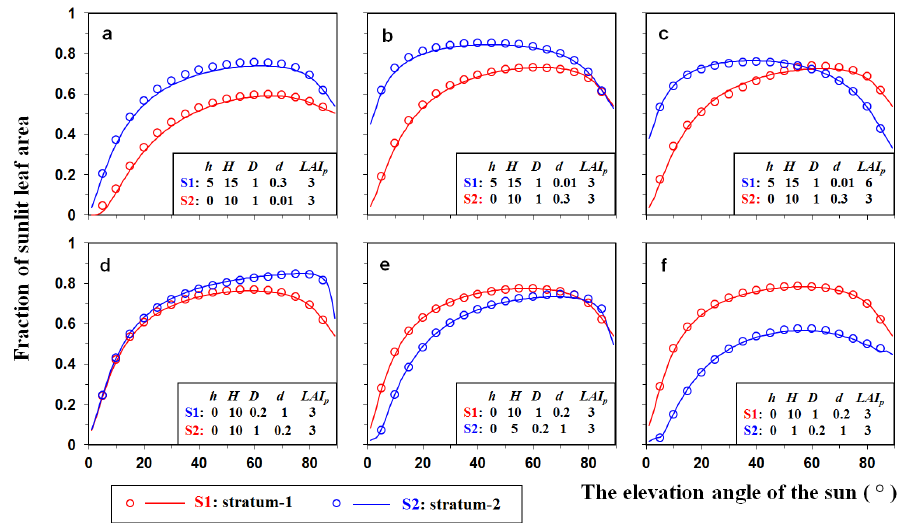
Figure 7. Comparisons of the calculated fractions of sunlit leaf area between the IPR model (curves) and the random approach (circles) for two-stratum plant communities. Red and blue are for stratum-1 (S1) and stratum-2 (S2), respectively. Their crown parameters are listed in each panel: H and h are the heights of the top and bottom of the crown, respectively (m), D is the width of the crown (m), d is the density of plants (plantsm − 2 ) , and LAI p is the local leaf area index (m 2 leafm − 2 ground).